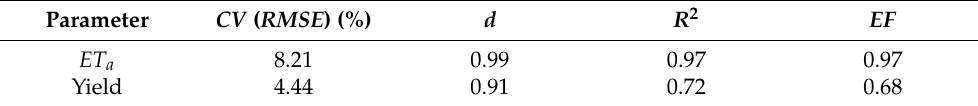
Table 3. Fit indexes of AquaCrop model-simulated and measured ET a and yield.